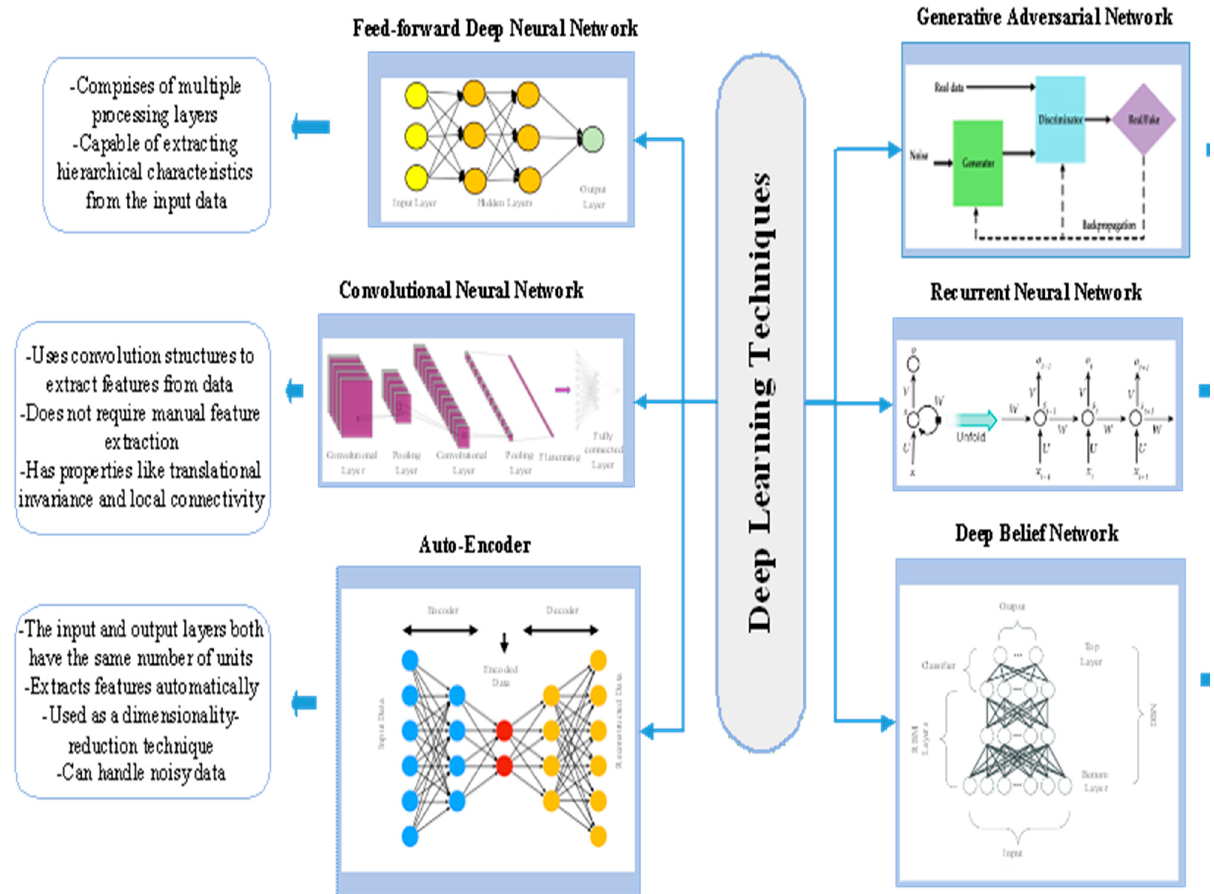
Figure 2. Deep learning techniques.